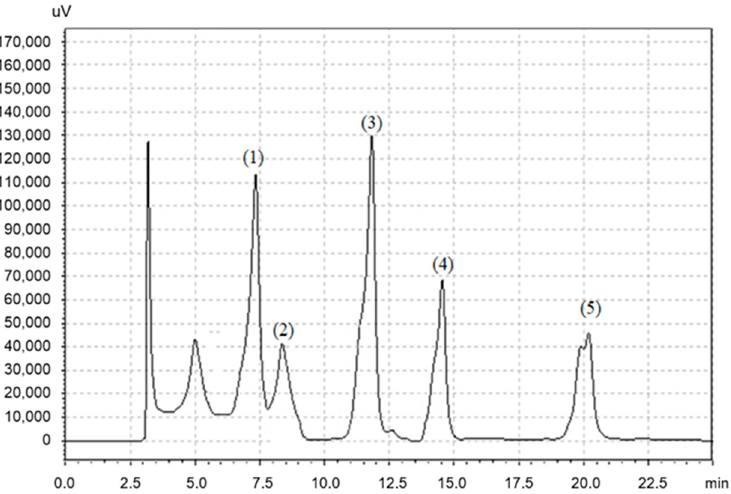
Figure 2. The chromatogram showing retention times and peak areas for lutein (1), zeaxanthin (2), chlorophyll b , (3) chlorophyll a , (4) β -carotene (5).